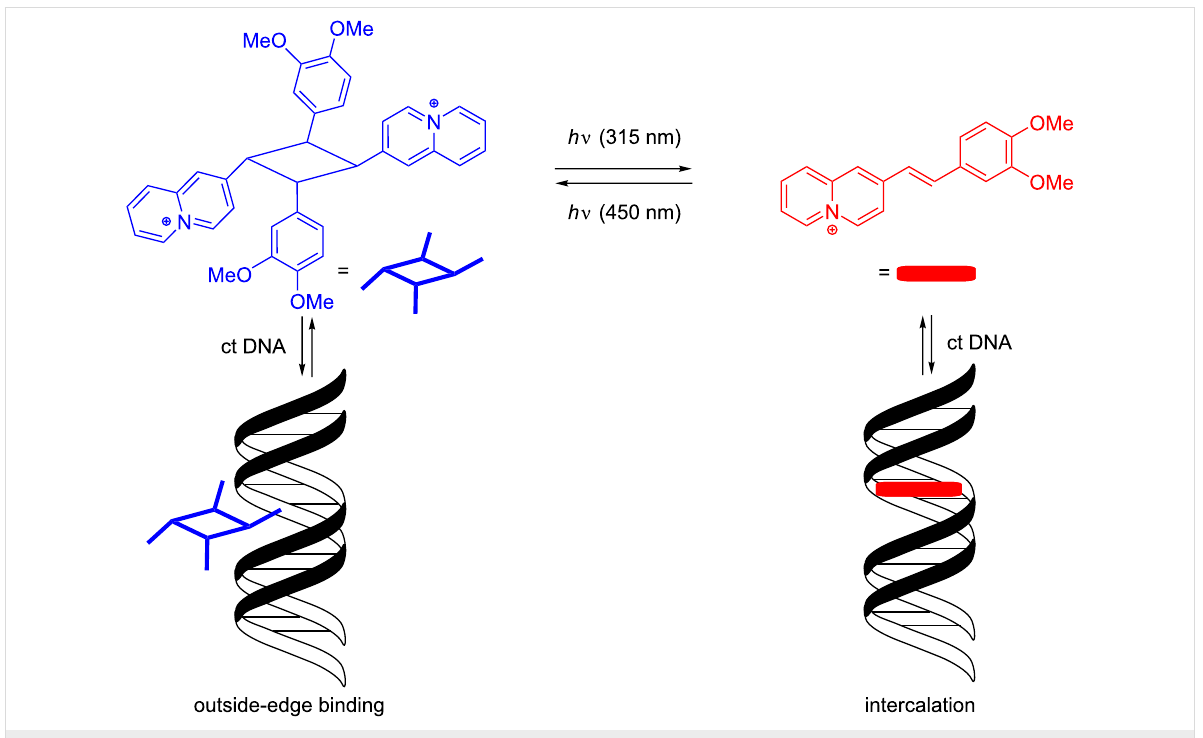
Scheme 3: Photoinduced switching of the DNA binding properties of styrylquinolizinium compound 3b .